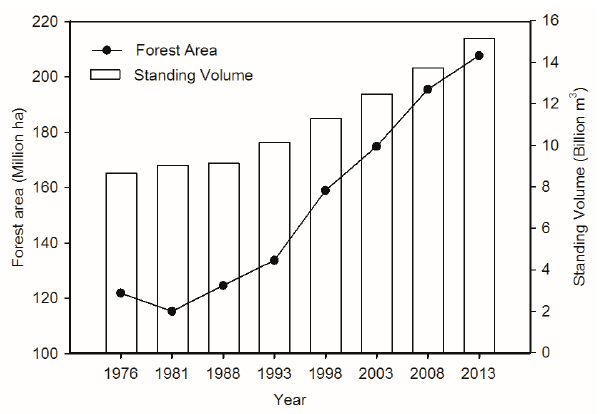
Figure 1. Forest area and growing stock of timber in China during 1976–2013.